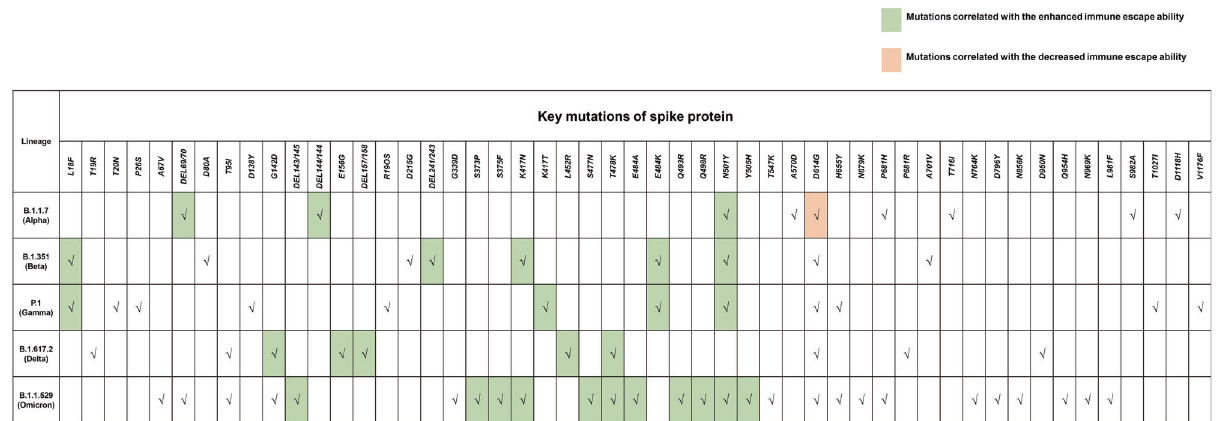
Fig. 7 A systemic illustration of the mutation in the S protein of VOCs. VOCs were designated by WHO because of the enhanced infectivity or immune escape ability (or with both), the speci fi c mutations in the S protein of VOC Alpha to Omicron are displayed, and the mutations related to enhanced immune escape ability were marked in green color, while the mutation related to decreased immune escape ability was marked into orange